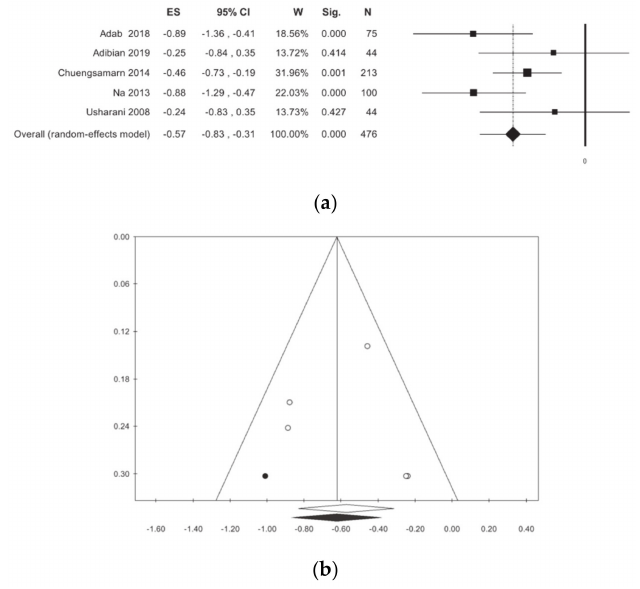
Figure 7. Meta-analysis results according to Triglycerides: ( a ) forest plot ( b ) funnel plot.